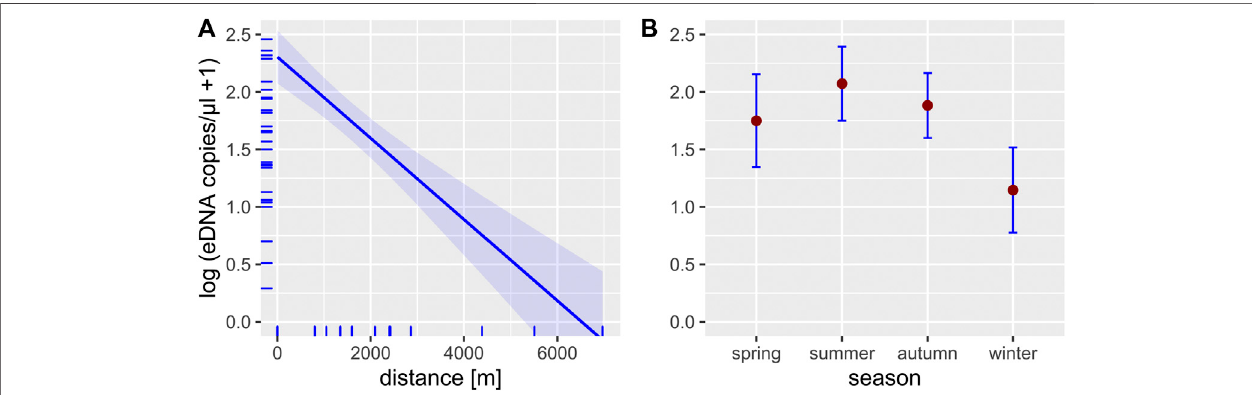
FIGURE 3 | Effect plots of the LMM used to predict the effect of the two independent variables distance (A) and season (B) on the eDNA concentration (blue- shaded areaand errorbarsrepresentthe95%con fi dence intervals; N (cid:1) 30, see Table5 formodelstatistics).Smallticksontheaxes indicate themarginal distribution of the